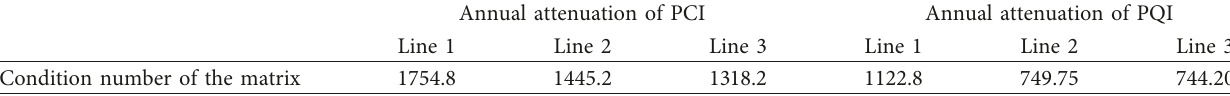
Table 4: Condition number of the GM (1, 1) model matrix using annual attenuations of PCI and PQI.